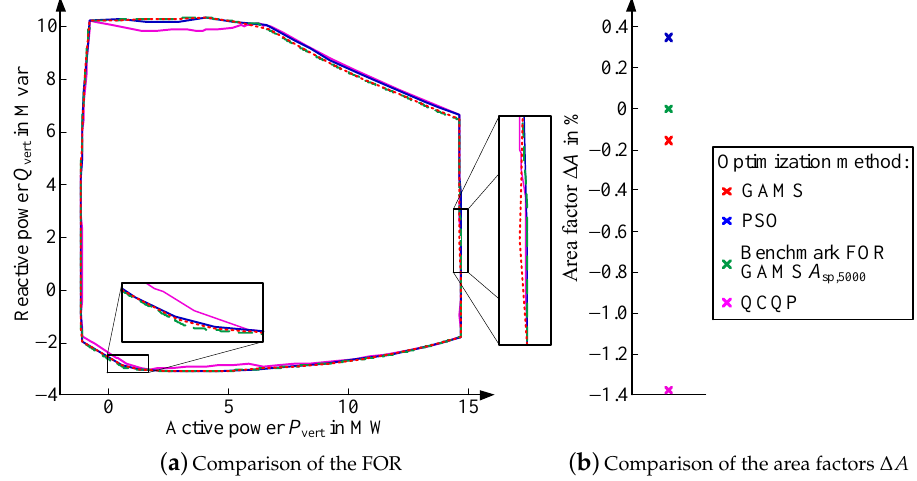
Figure 7. Comparison of the optimization methods for the FOR determination.